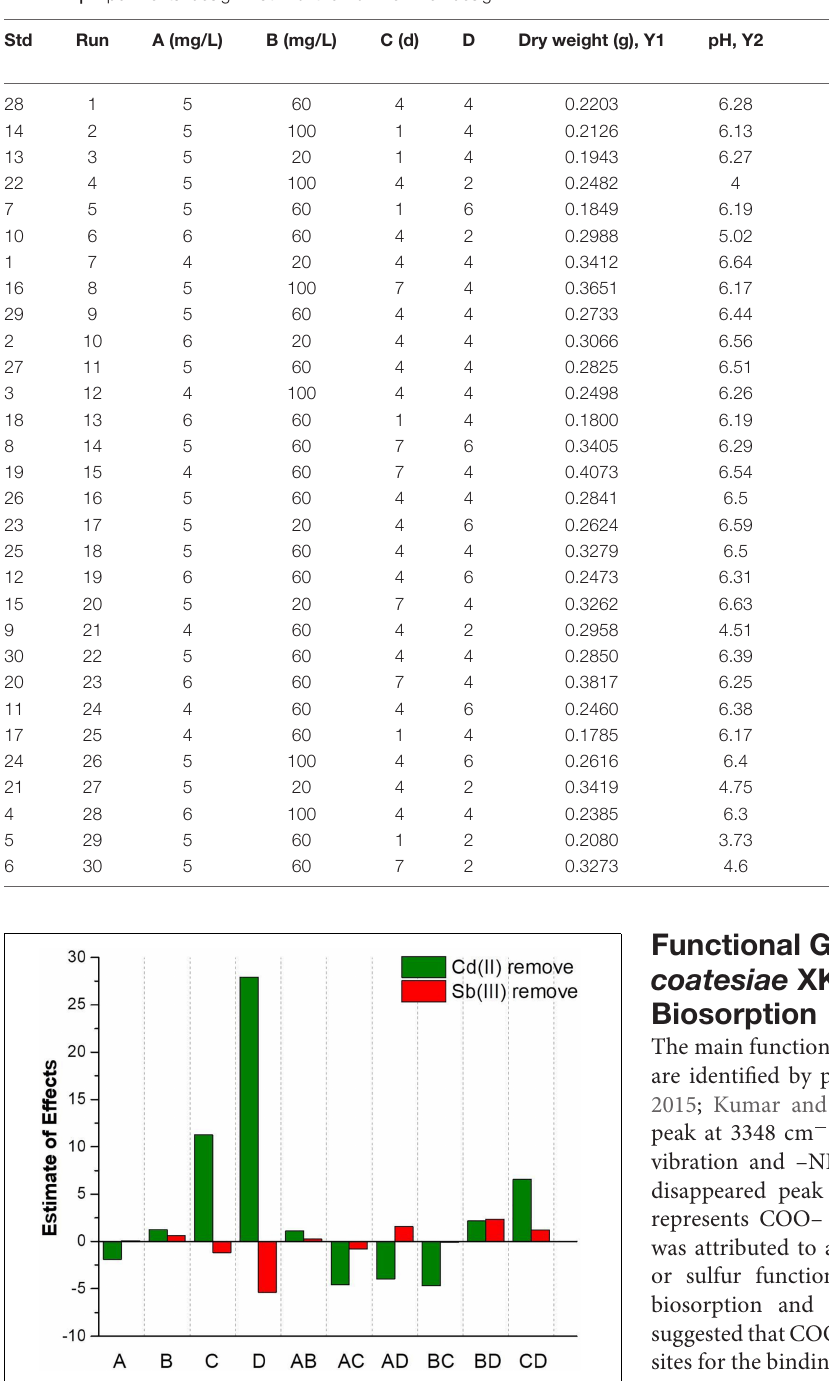
experimenting with the best removal conditions for Cd(II) and Sb(III), the actual maximum removal rates of Cd(II) and Sb(III) were 67.57 and 16.75% ( Table 3